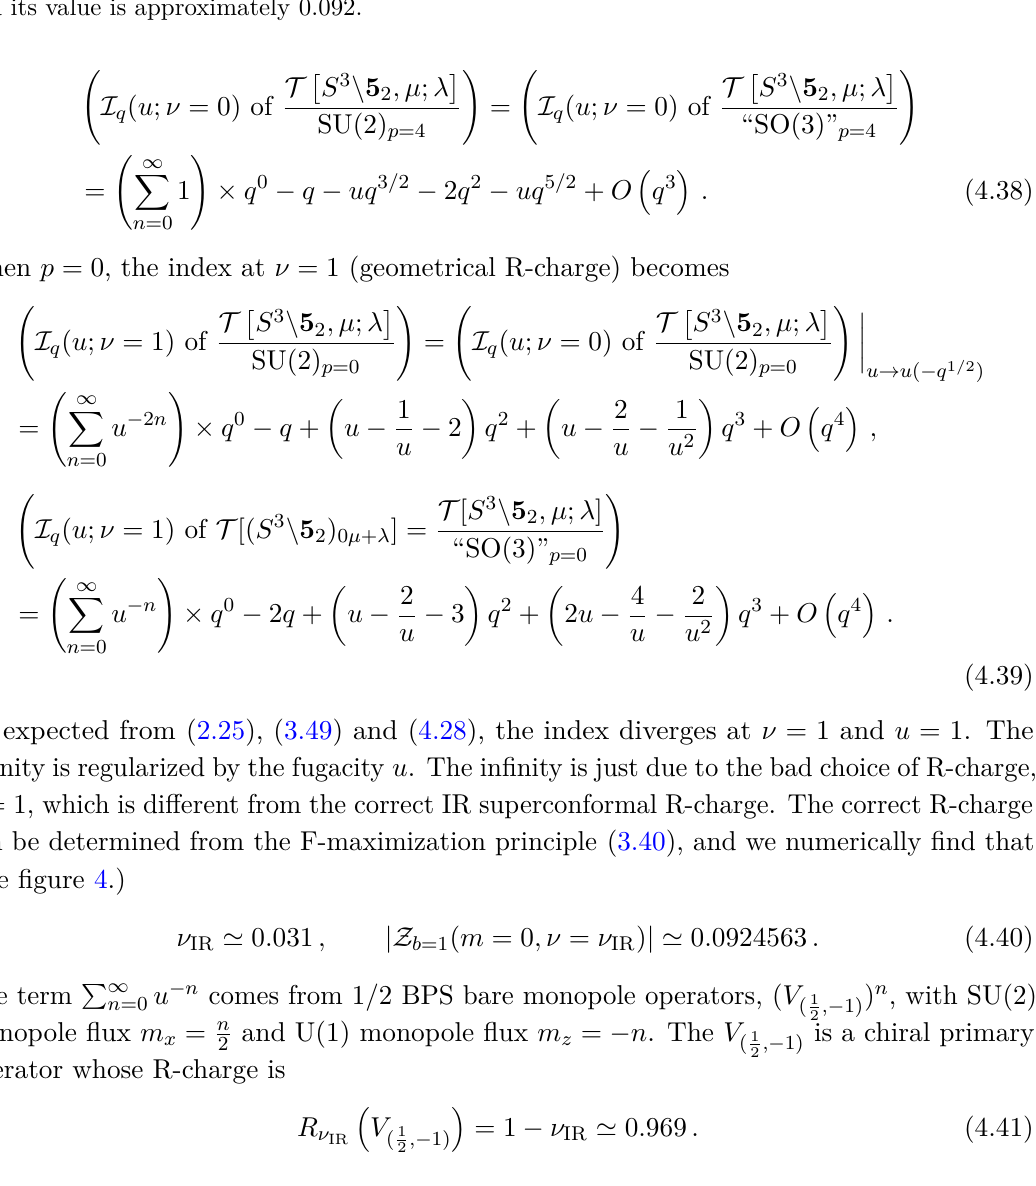
( m = 0 , ν ) | as a function of ν ∈ ( − 2 , 2) . The minimum is located at ν ' 0 . 031 Figure 4 . |Z (5 2 ) p =0 b =1 and its value is approximately 0 . 092